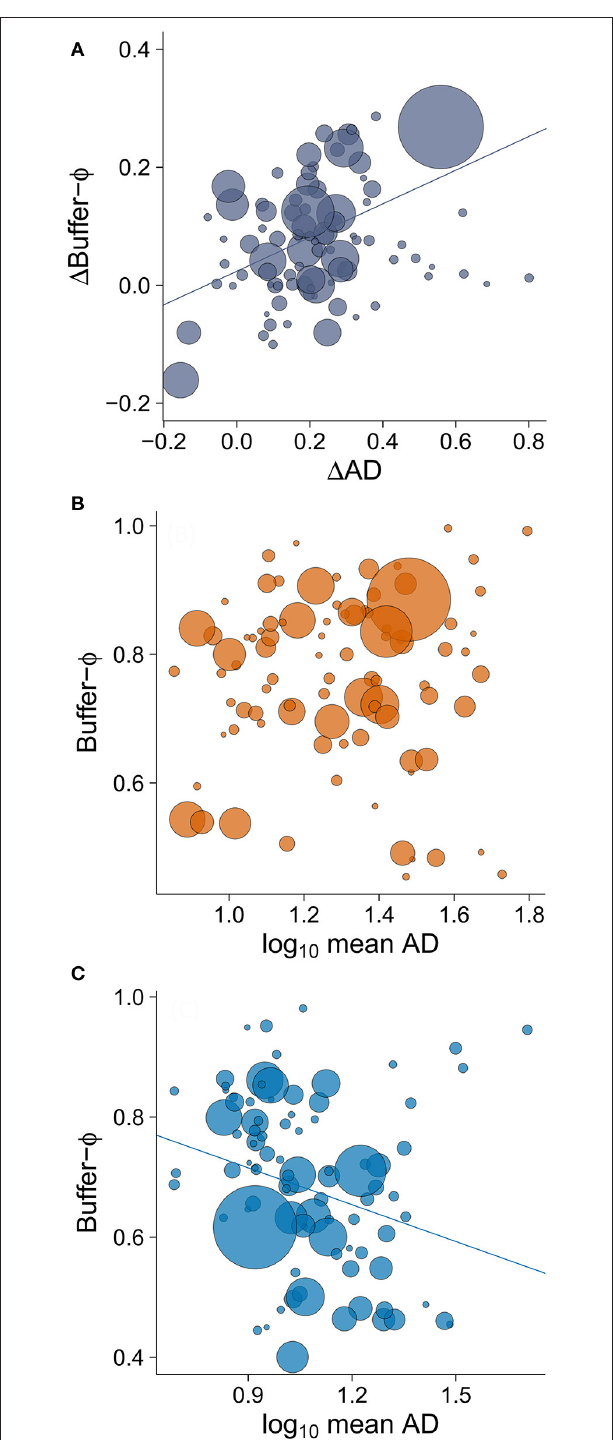
FIGURE 5 | The relationship between (A) rural-urban difference in mean alert distance ( 1 AD) and rural-urban difference in buffer- 8 ( 1 buffer- 8 ), and the relationship between mean AD and buffer- 8 in (B) rural and (C) urban sites. Lower values of buffer- 8 mean that birds tolerate more human approach after detection. The size of the circles is proportional to sample size for a given population (plot A: min = 19, max = 358; plot B: min = 8, max = 122; plot C, min = 8, max = 275). Lines illustrate linear